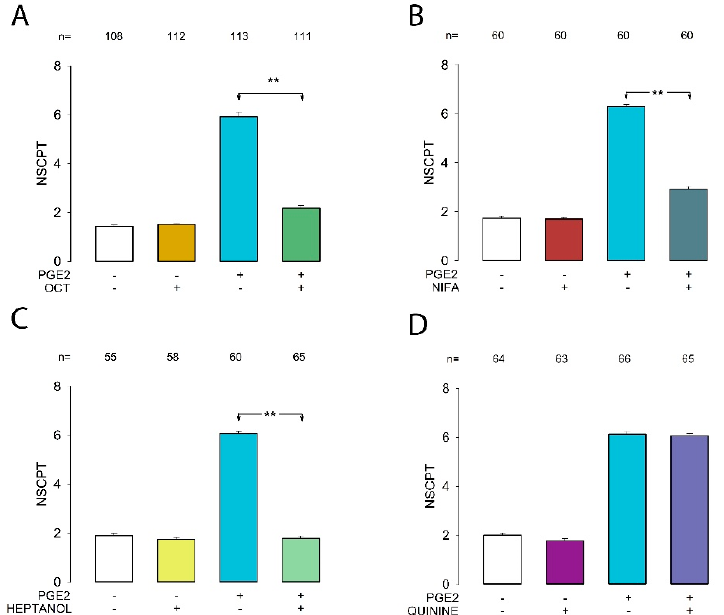
Figure 2. Effect of gap junction blockers on the PGE2-induced enhancement of gap junctional intercellular communication (GJIC). Bar charts ( A – D ) show the effect of octanol (OCT), niflumic acid (NIFA), heptanol, and quinine, respectively. Bars show the mNSCPT ( ± standard error of the mean (SE)) under each experimental condition indicated at the bottom. The ** above bars indicate a statistically significant difference ( p < 0.001) between the groups indicated by the bars. The numbers above each bar indicate the number of repeats under each experimental condition.